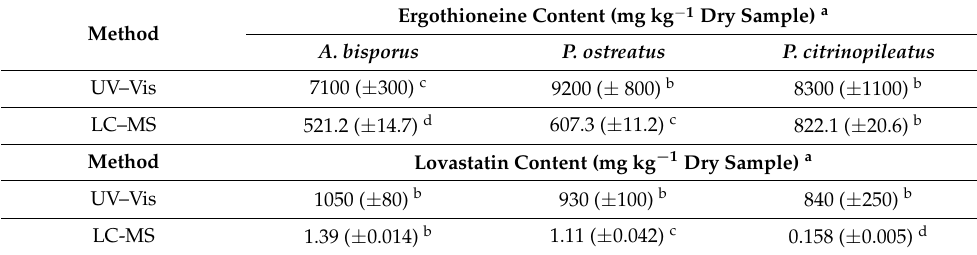
Table 3. Ergothioneine–Lovastatin content in mushrooms of three species cultivated in conventional substrates by using ultraviolet-visible (UV–Vis) spectroscopy and